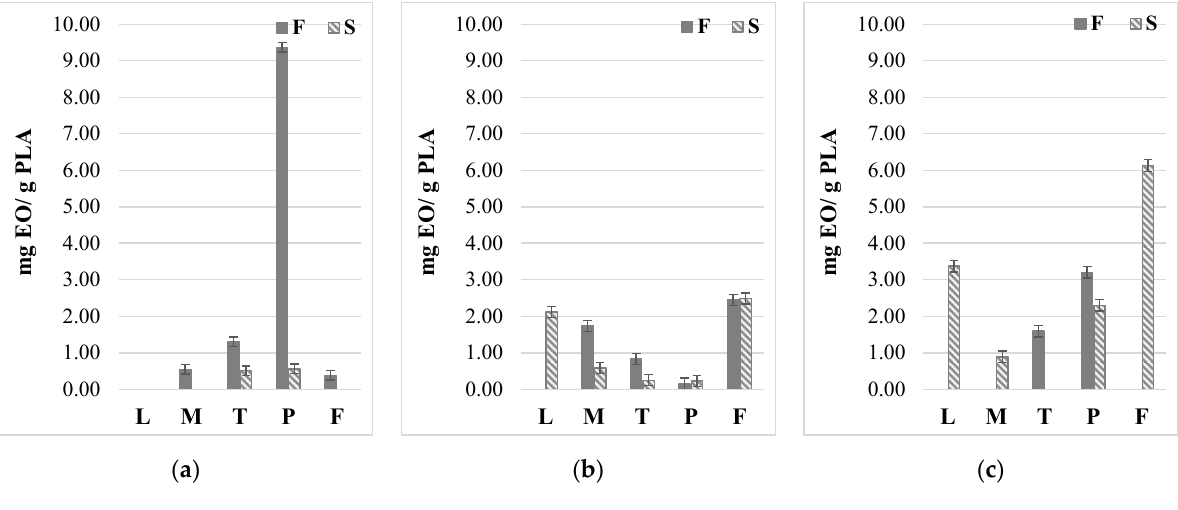
Figure 6. The specific amount of essential oil in hexane solutions at different concentrations: ( a ) 1 wt.% solution; ( b ) 1.5 wt.% solutions; ( c ) 2 wt.% solutions.